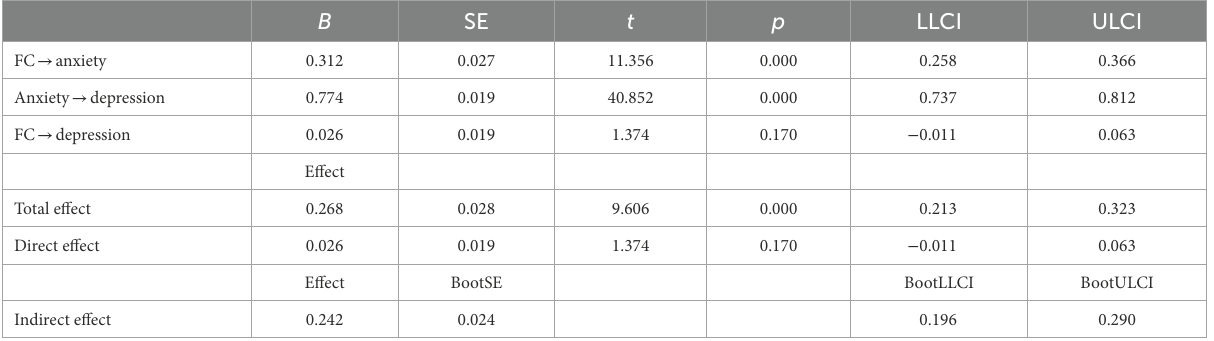
TABLE 4 Mediating effect